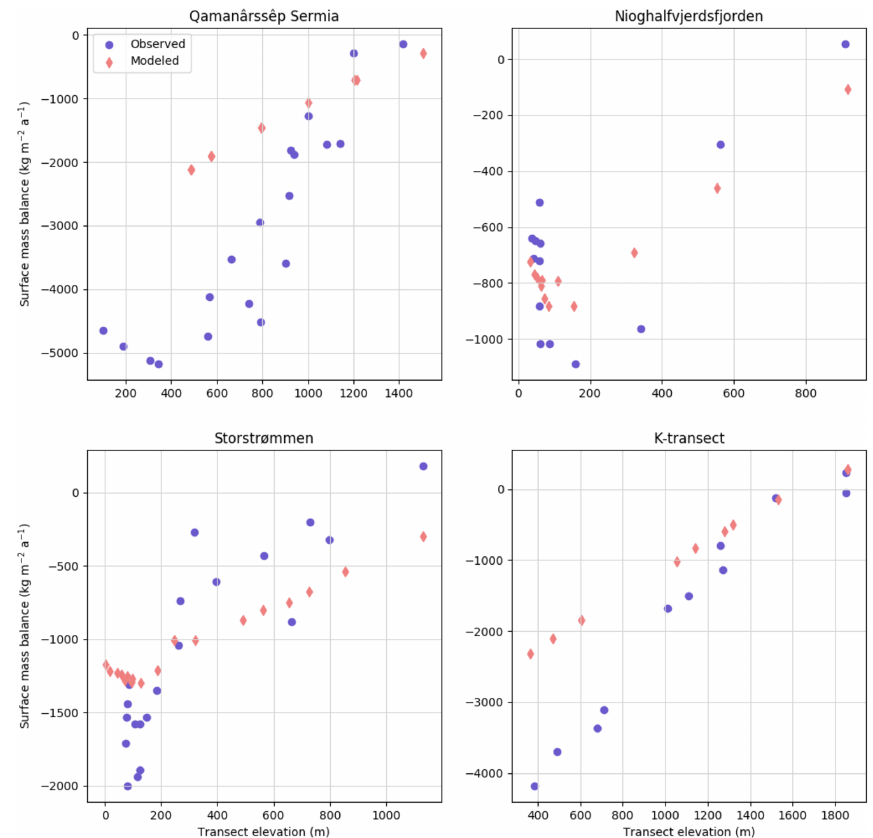
Figure 16. Annual surface mass balance as a function of observed elevation at four different areas in the ablation zone of GrIS. Red dots are modeled SMB and elevation, while blue dots are observed SMB and elevation from pit/core field estimates. Observational data were compiled from the PROMICE database (Machguth et al.,